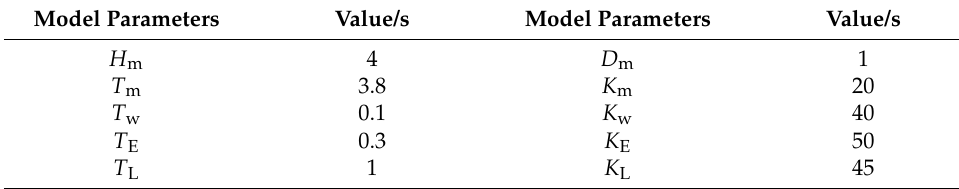
Table 1. Frequency control model parameters for each resource. Model